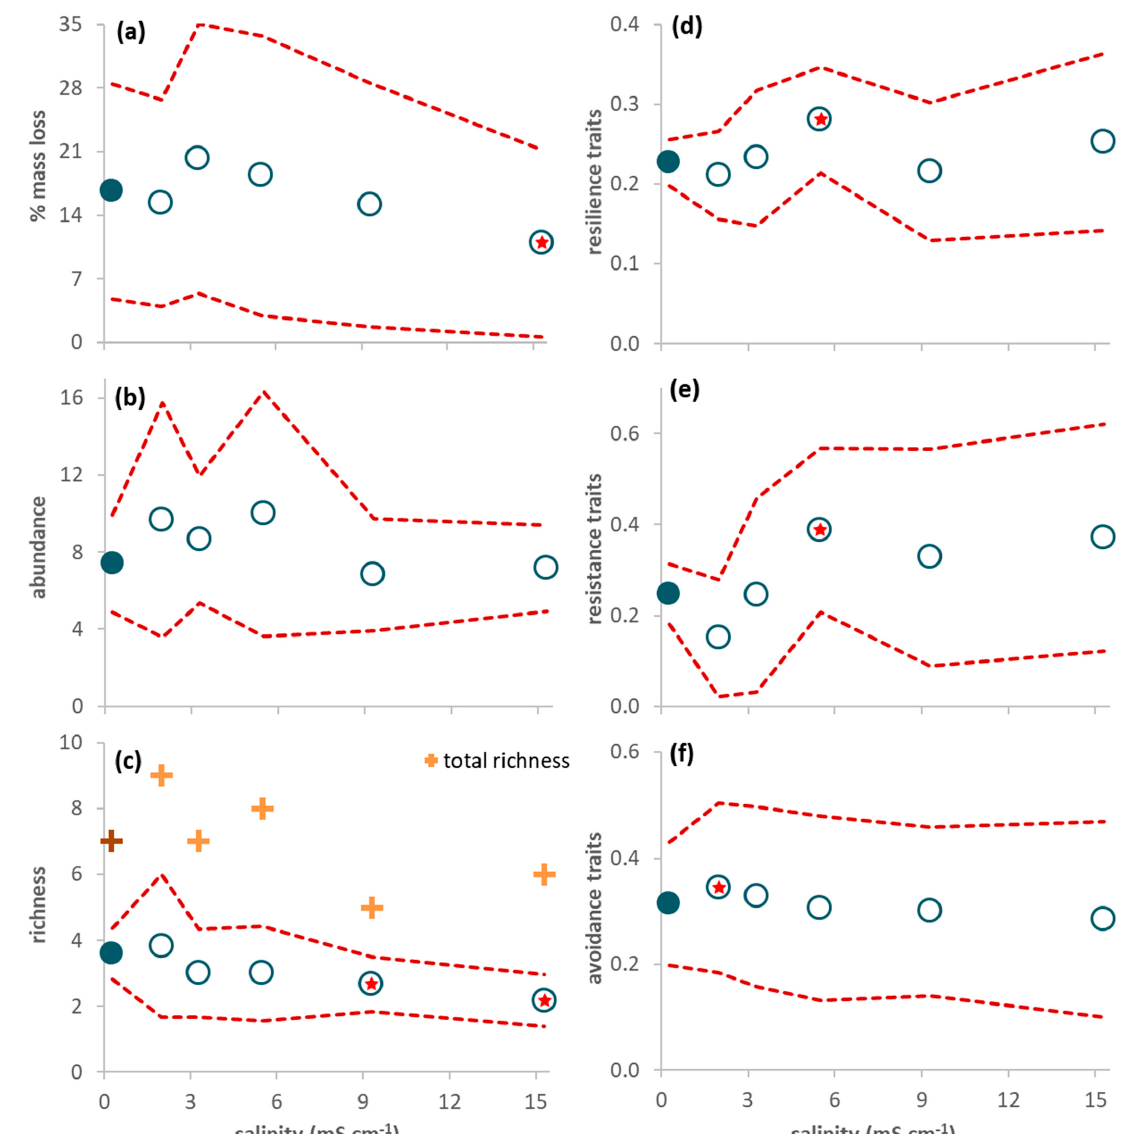
Figure 1. Response variables of the decomposition experiment during the 63-day study period (average per leaf pack ± 95% confidence limits (red dashed line); n = 6). ( a ) Leaf mass loss; ( b ) Invertebrate abundance; ( c ) Invertebrate richness (plus symbols refer to total (instead of average) richness: dark color for the control and light color for the treatments); ( d ) Proportion of resilience traits (short lifespan, ovoviviparous reproduction, and aerial respiration); ( e ) Proportion of resistance traits (multivoltinism); ( f ) Proportion of avoidance traits (non-aquatic life stages and terrestrial reproduction). A red star indicates a net average deviation of the values in a treatment (open circles) in relation to the values in the control (close circles) according to Table 2.